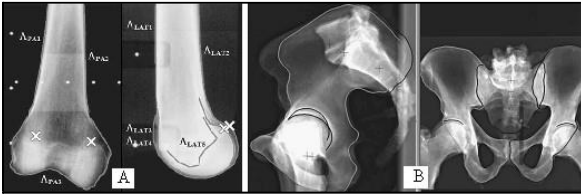
Figure 2. Identification of anatomical contours on the radiographs for: (A) distal femur (S. Laporte et al, 2003), (B) pelvis (S. Mitton et al,